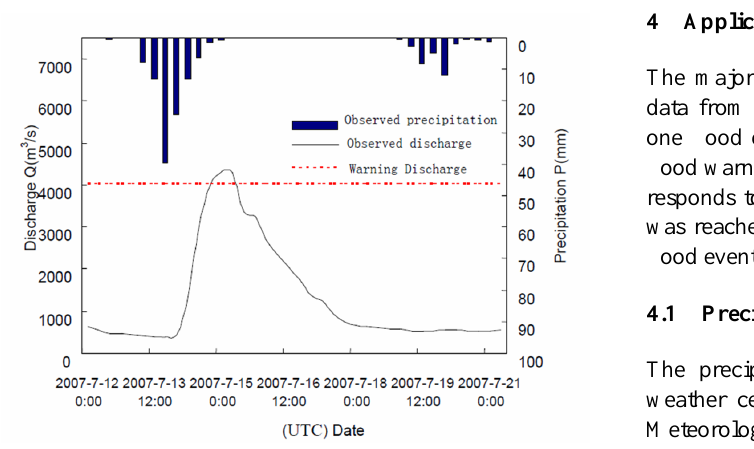
Fig. 2. Observed 6-hourly precipitation and discharge at Xixian